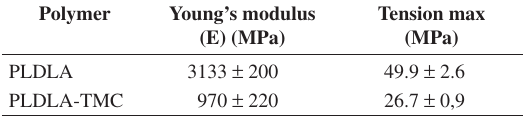
Table 7. Mechanical properties of PLDLA and PLDLA-TMC